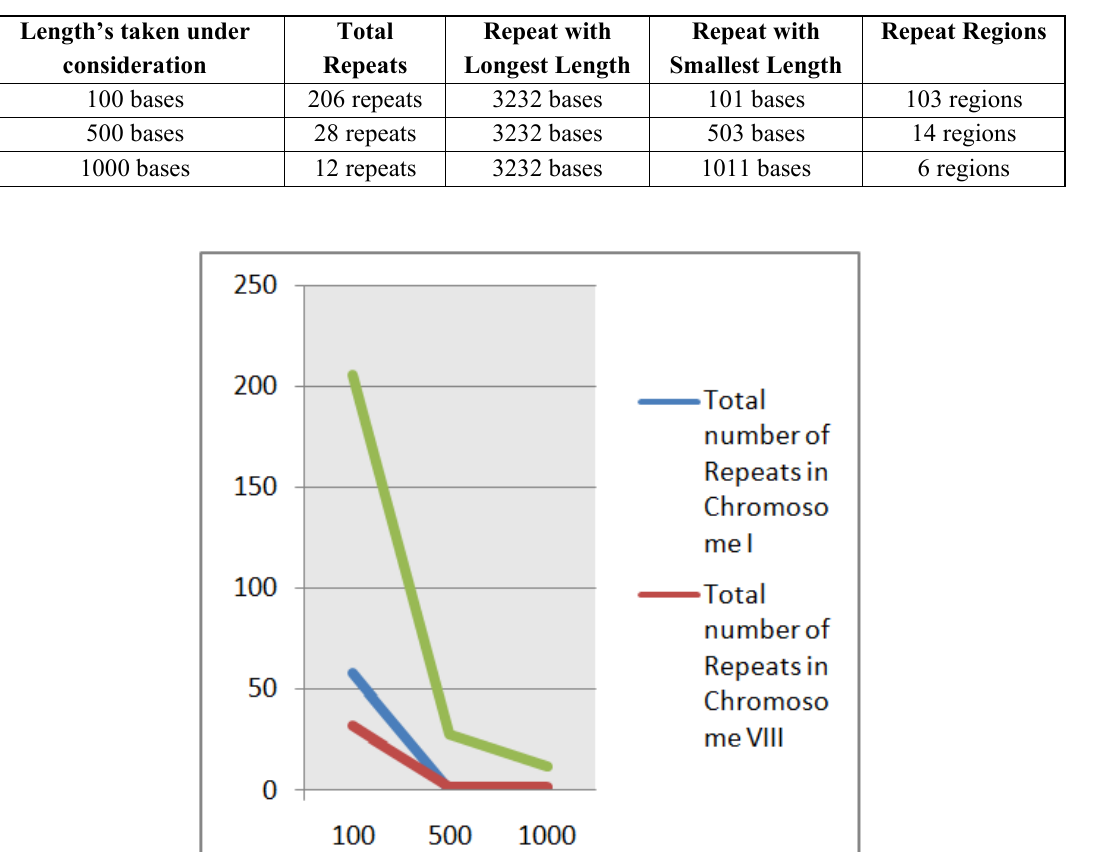
EAI Endorsed Transactions on Pervasive Health and